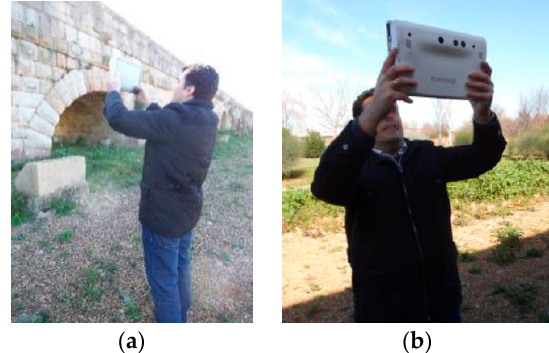
Figure 5. Used targets.